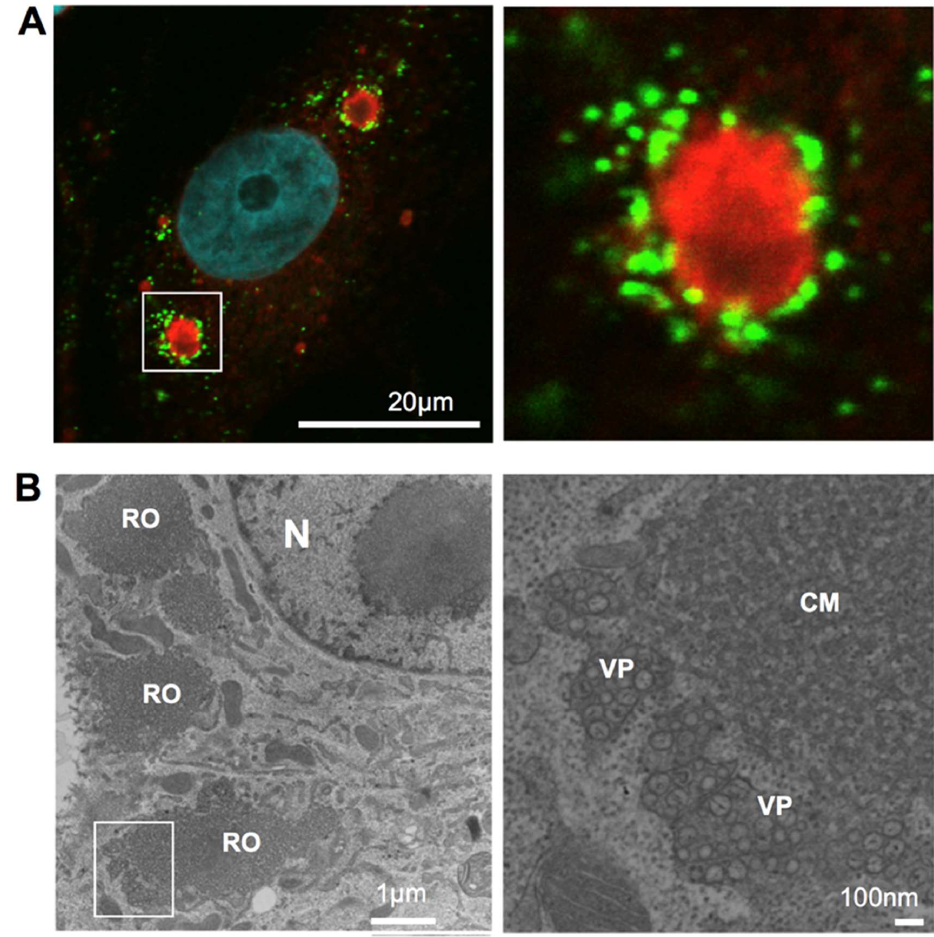
Figure 1. Viral replication organelle in Japanese encephalitis virus (JEV)-infected cells. ( A ). fluorescent imaging of JEV replication organelle. At 48 h post-infection, JEV infected Vero cells were fixed, permeabilized, and stained with anti-nonstructural protein 4B (NS4B; red) and anti-double stranded RNA (dsRNA; Green) antibodies. Nuclear DNA was stained with DAPI (blue). Scale bar: 20 microns. ( B ). Viral replication organelle structure visualized using transmission electron microscopy (TEM). At 48 h post-infection, JEV infected Vero cells were fixed, ultra-thin section, and observed using TEM. N, nucleus; RO, viral replication organelle; CM, convoluted membrane; VP, vesicle packet. Scale bar = 1 micron (left) or 100 nm (right).